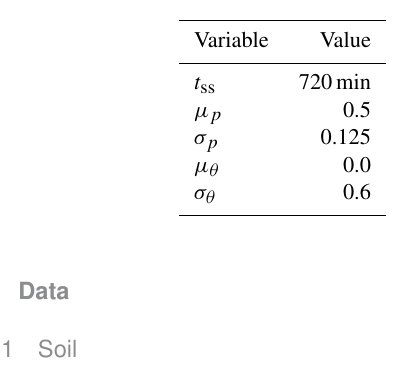
Figure 2. Time evolution of pore-water pressures and water content for the dual-porosity model. Table 1. Hydrological parameters used in all